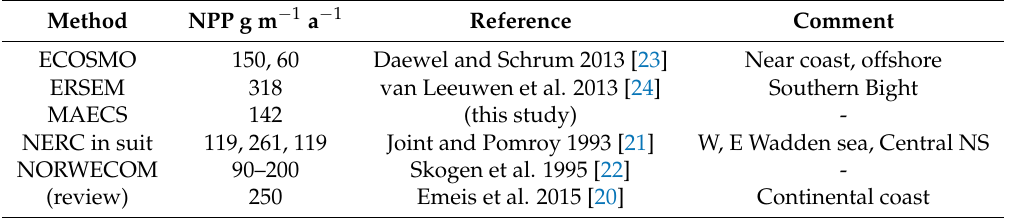
Table 1. Estimates for annual net primary productivity in the southern North Sea.